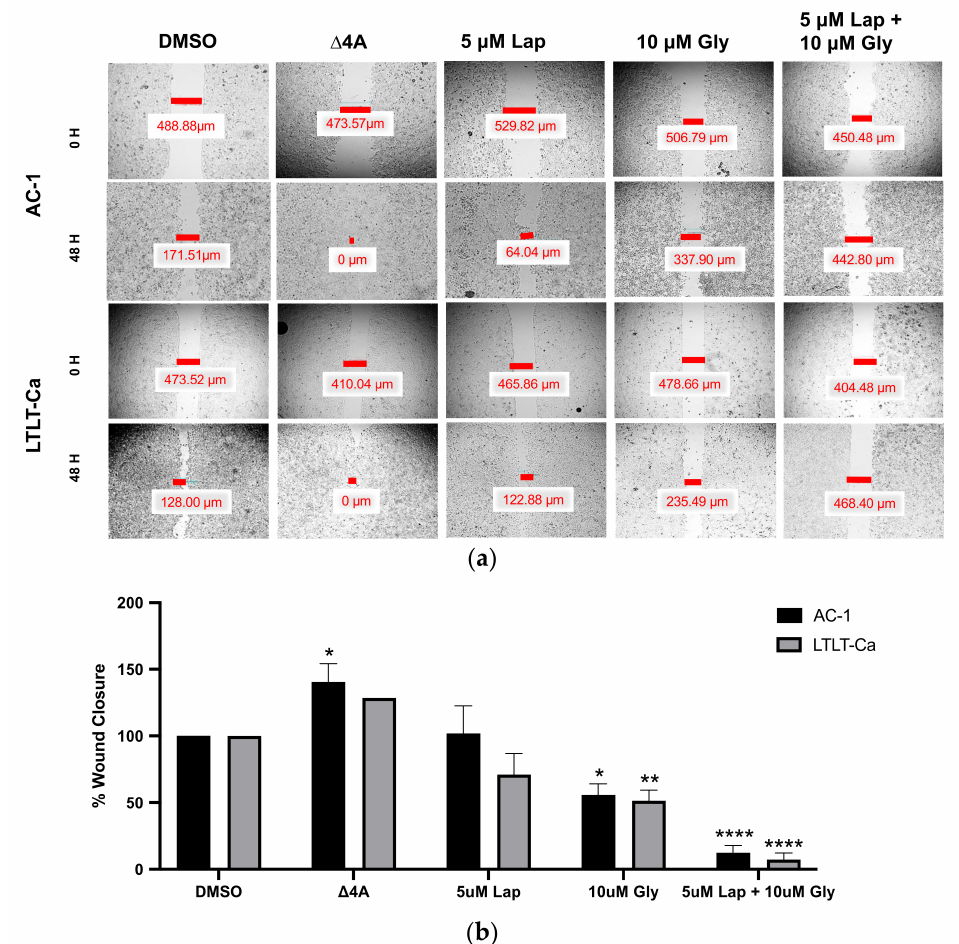
Figure 3. Lapatinib potentiates glyceollin-induced cell motility. Migration assays were performed using the AC-1 cells and the LTLT-Ca cells. Both cell lines were cultured in standard growth media and treated for 24 h with DMSO vehicle control, 25 nM androstenedione ( ∆ 4A), 5 µ M lapatinib, 10 µ M glyceollin, and 5 µ M lapatinib + 10 µ M glyceollin as described in methodology. ( a ) Images depict the wound distance at 0 h and 48 h. ( b ) Graphical representation of the percentage of the wound closure. Two-way ANOVA analysis were conducted, and treatments were compared to the control. Results are expressed as the mean unit ± standard deviation of three independent experiments in triplicate. (**** p < 0.0001, ** p < 0.01, * p < 0.05) of three independent experiments in